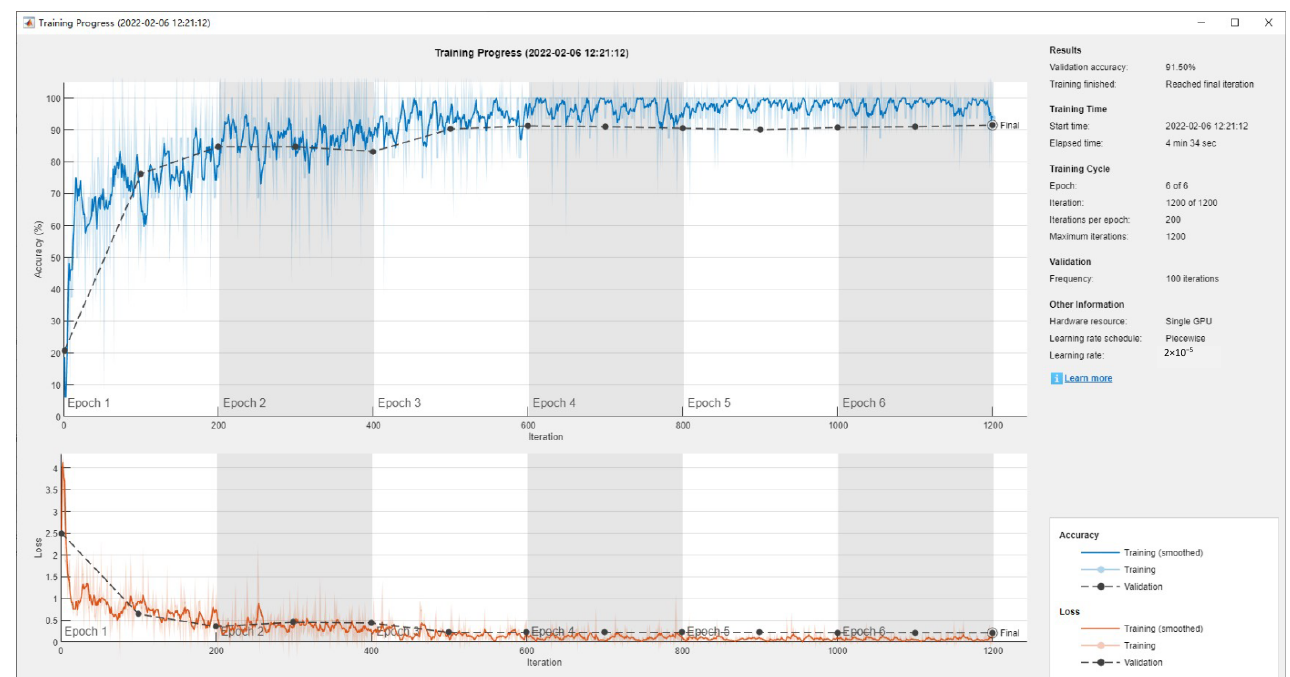
Figure 4. Training progress screenshot graph of the GoogLeNet model in MATLAB.